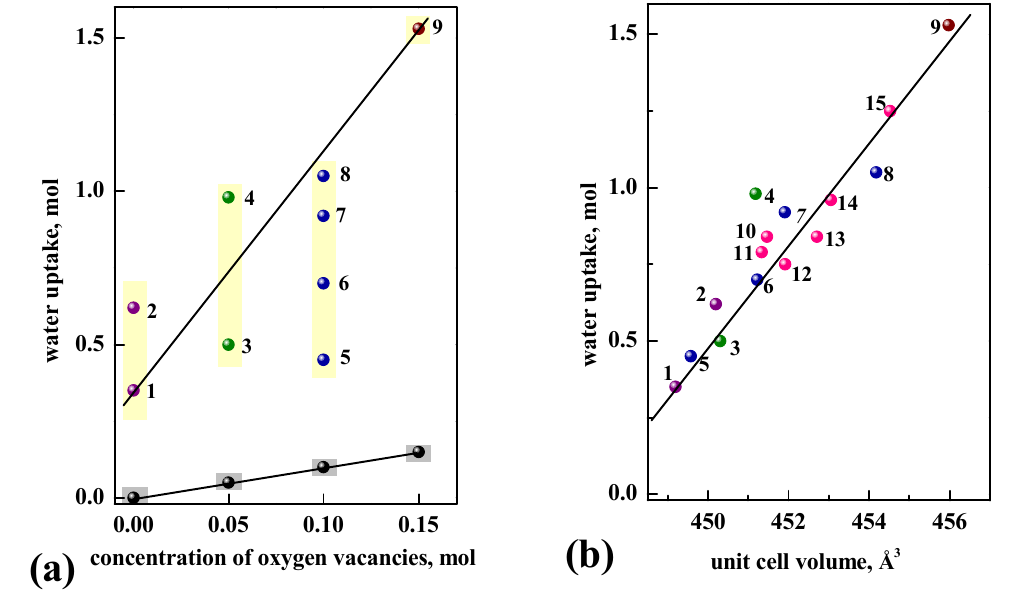
Figure 4. The dependencies of water uptake vs. concentration of oxygen vacancies ( a ) and unit cell volume ( b ) for the compositions BaLaIn 0.9 Sc 0.1 O 4 (1) [83], BaLaInO 4 (2) [74], Ba 1.05 La 0.95 InO 3.975 (3) [79], Ba 1.1 La 0.9 In 0.95 Ti 0.05 O 3.98 (4) [81], Ba 1.1 La 0.9 In 0.95 Ti 0.1 O 4 (5) [81], BaLa 0.9 Ca 0.1 InO 3.95 (6) [74], BaLa 0.9 Sr 0.1 InO 3.95 (7) [74], Ba 1.1 La 0.9 InO 3.95 (8) [79], Ba 1.15 La 0.85 InO 3.925 (9) [79], BaLaIn 0.95 Ti 0.05 O 4.025 (10) [80], BaLaIn 0.95 Nb 0.05 O 4.05 (11) [84], BaLaIn 0.9 Zr 0.1 O 4.05 (12) [78], BaLaIn 0.9 Nb 0.1 O 4.10 (13) [84], BaLaIn 0.9 Ti 0.1 O 4.05 (14) [80], BaLaIn 0.85 Ti 0.15 O 4.075 (15) [80]. The violet, green/blue/red, and rose symbols correspond to the compositions without oxygen defects, with oxygen vacancies and oxygen interstitials in the structure correspondingly.